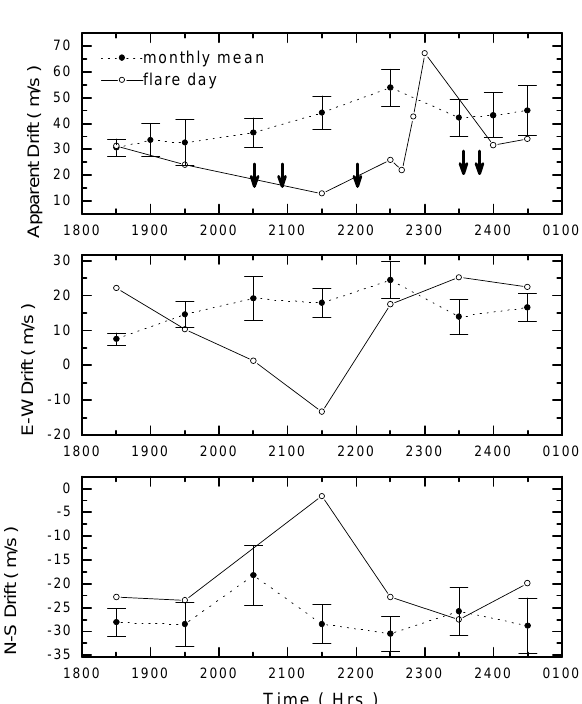
Fig. 4. Variation of Apparent Drift Speed, its E–W and N–S compo- nents on 10 August 1982, along with their respective monthly mean variation. Solar flares occurred at 20:31, 20:55 and 22:01 (2N), and 23:34 and 23:48 (1N). The rest of the details are the same as in Fig. 1.